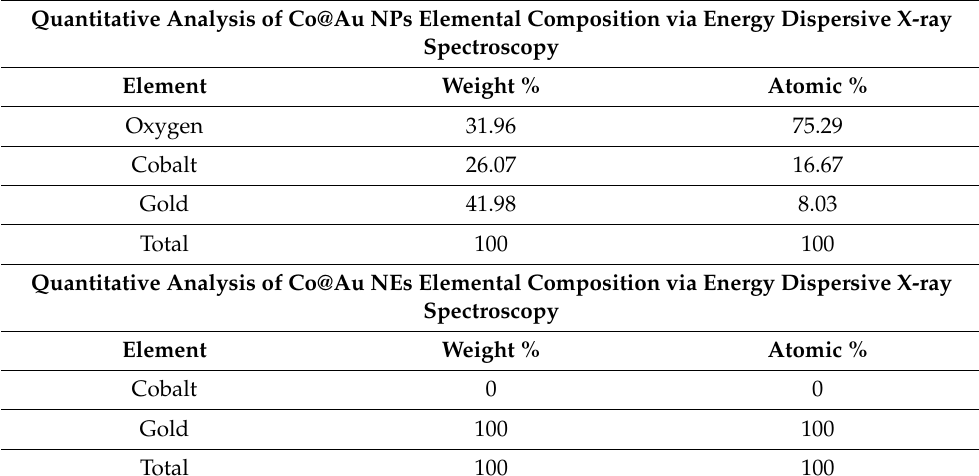
Table 1. Analysis of Co@Au NPs and Co@NEs